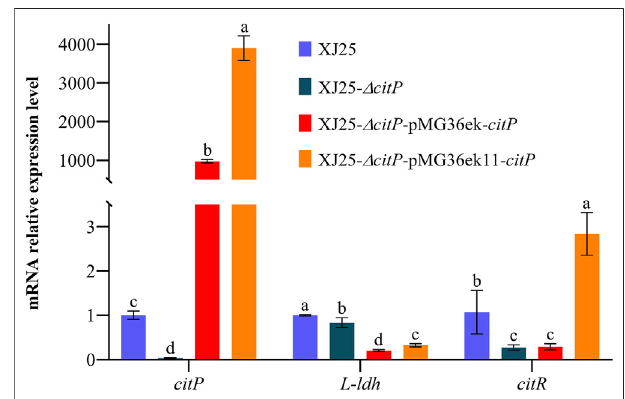
FIGURE1| DeterminationofcitP,L-ldh,andcitRgeneexpressionlevels in the wild-type XJ25 and the mutants. Data are expressed as mean ± standard deviation ( n = 3). a-d means with different lower-case letters in the same row indicate signi fi cant differences ( p <